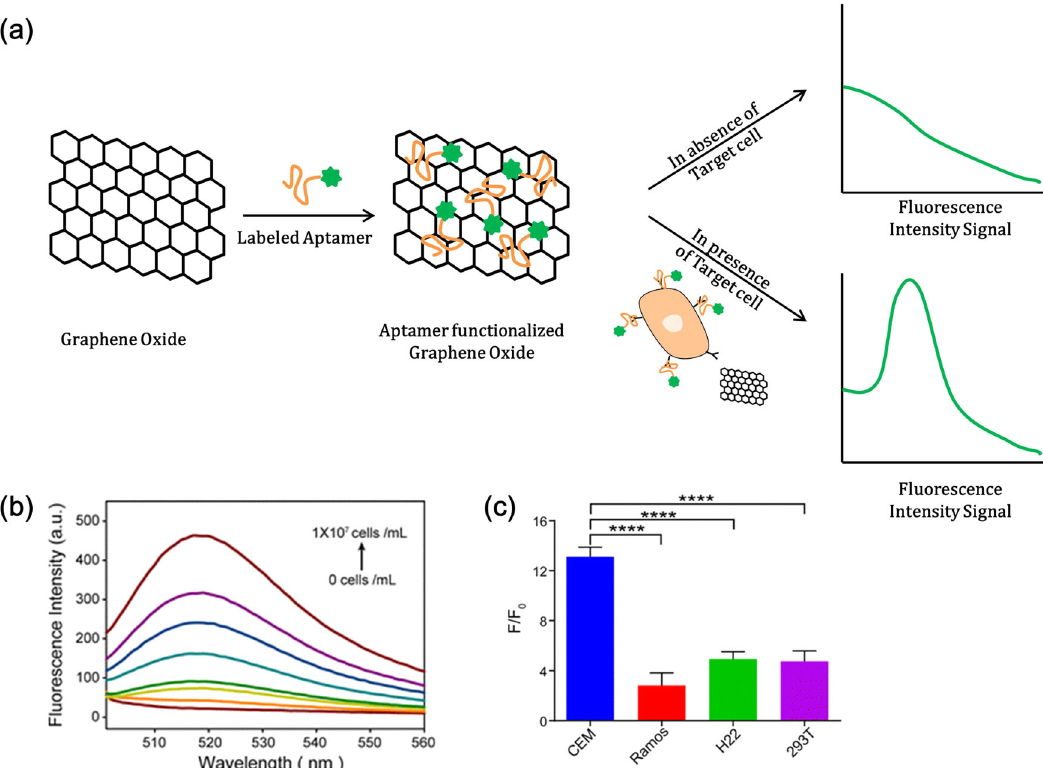
Fig. 8 Detection of CCRF-CEM cells. a Schematic fi gure of the GO and FAM – Apt-based fl uorescent material for detection of CCRF-CEM cells. b The fl uorescence intensity increases with an increase in the number of CCRF-CEM cells from 0 to 1 × 10 7 indicating ef fi ciency, and c the CCRF- CEM gets higher fl uorescence intensity than the other control groups, implying high speci fi city of the hybrid material for CCRF-CEM cell detection. Adapted with permission from ref. 68 , Copyright 2018,